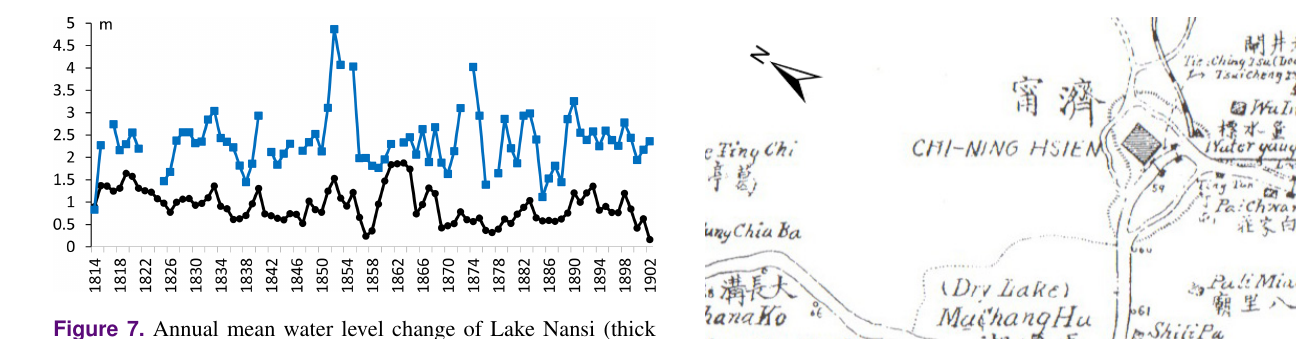
Figure 7. Annual mean water level change of Lake Nansi (thick blue line with squares) over 1814–1902 and its comparison with the annual mean water level of Lake Machang (thin black line with dots).